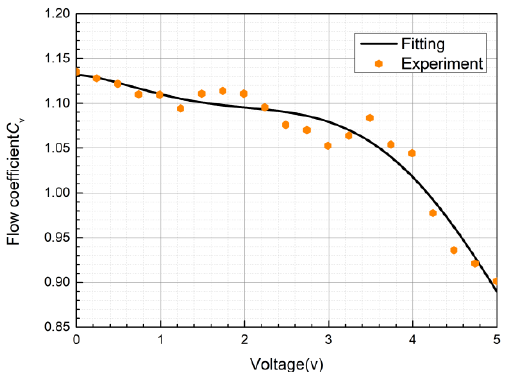
Figure 11. Graph of flow coefficients and control voltages.